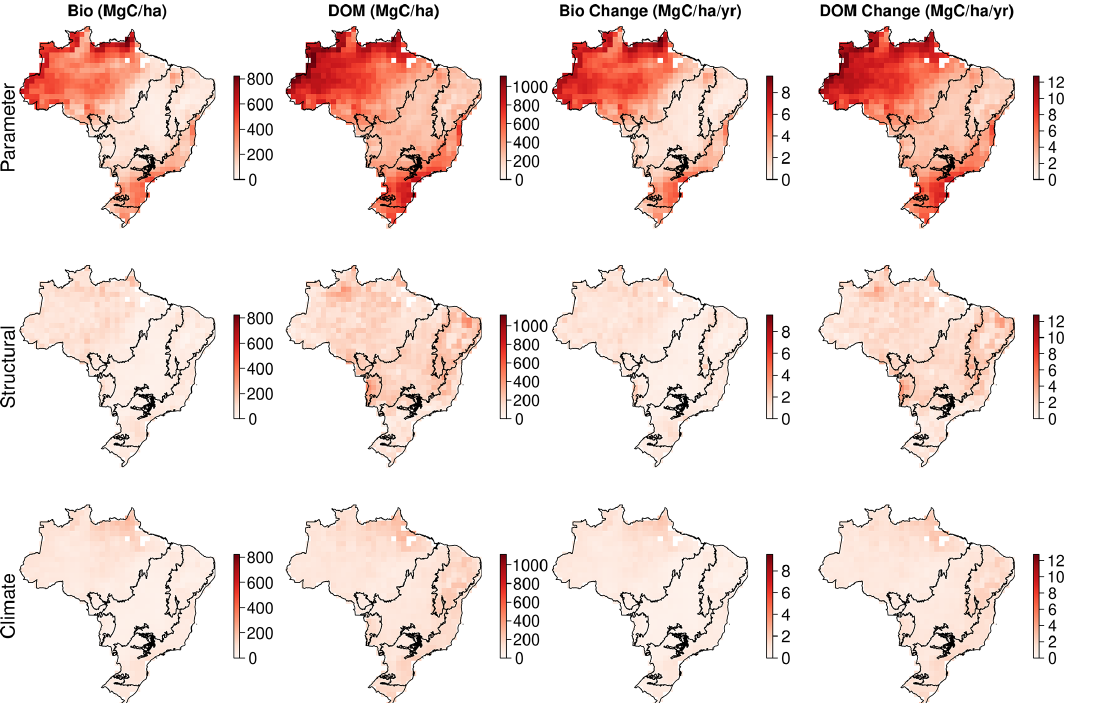
Figure A17. Absolute uncertainty range (5%–95% quantiles) simulated for each pixel in 2100 attributed to model parameters, model structural diversity and climate change